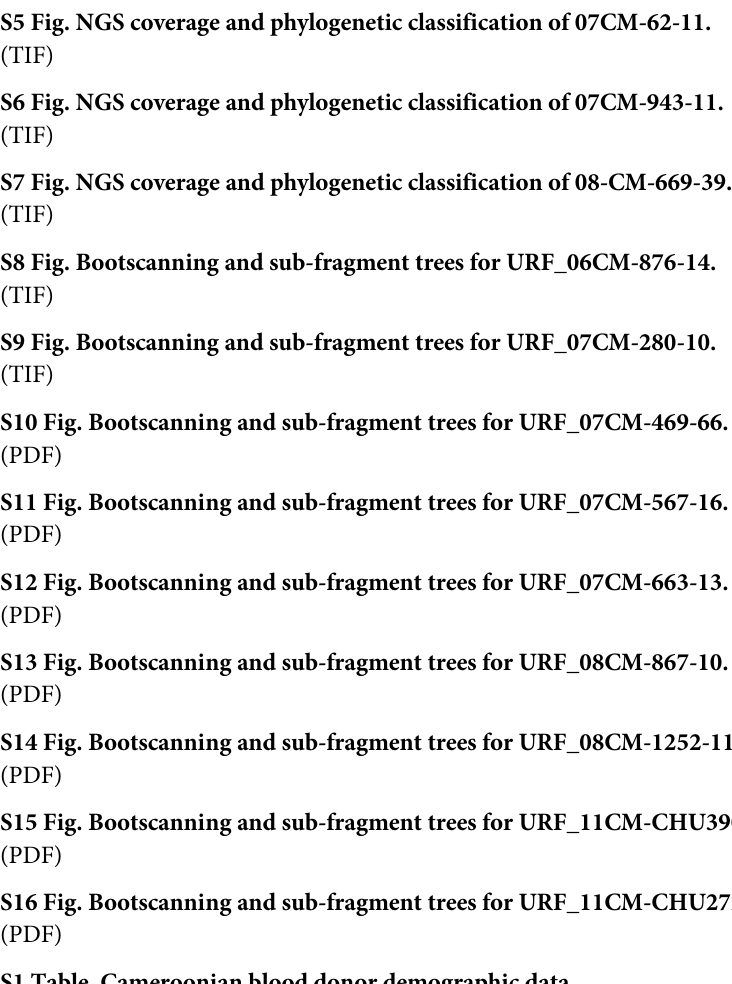
(TIF) S6 Fig. NGS coverage and phylogenetic classification of 07CM-943-11. (TIF) S7 Fig. NGS coverage and phylogenetic classification of 08-CM-669-39. (TIF) S8 Fig. Bootscanning and sub-fragment trees for URF_06CM-876-14. (TIF) S9 Fig. Bootscanning and sub-fragment trees for URF_07CM-280-10. (TIF) S10 Fig. Bootscanning and sub-fragment trees for URF_07CM-469-66. (PDF) S11 Fig. Bootscanning and sub-fragment trees for URF_07CM-567-16. (PDF) S12 Fig. Bootscanning and sub-fragment trees for URF_07CM-663-13. (PDF) S13 Fig. Bootscanning and sub-fragment trees for URF_08CM-867-10. (PDF) S14 Fig. Bootscanning and sub-fragment trees for URF_08CM-1252-11. (PDF) S15 Fig. Bootscanning and sub-fragment trees for URF_11CM-CHU3903. (PDF) S16 Fig. Bootscanning and sub-fragment trees for URF_11CM-CHU2727. (PDF) S1 Table. Cameroonian blood donor demographic data.